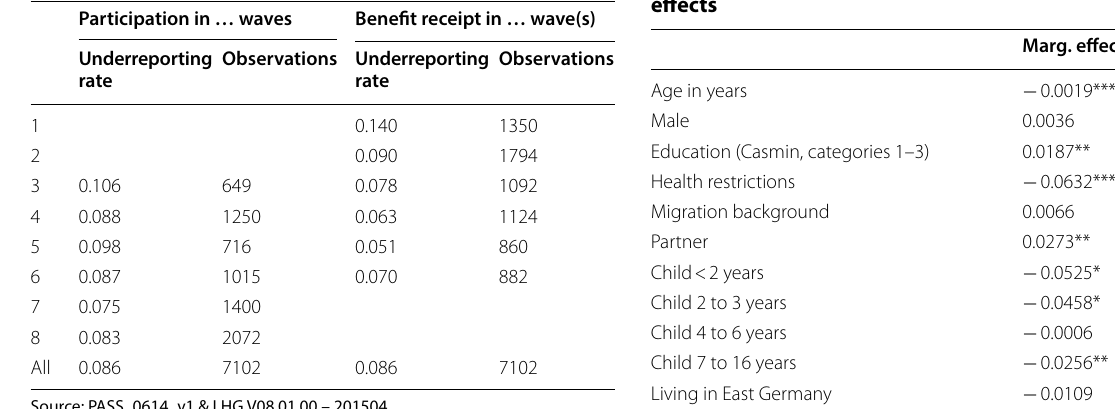
Table 4 Benefit underreporting by panel participation and benefit receipt in the analysis